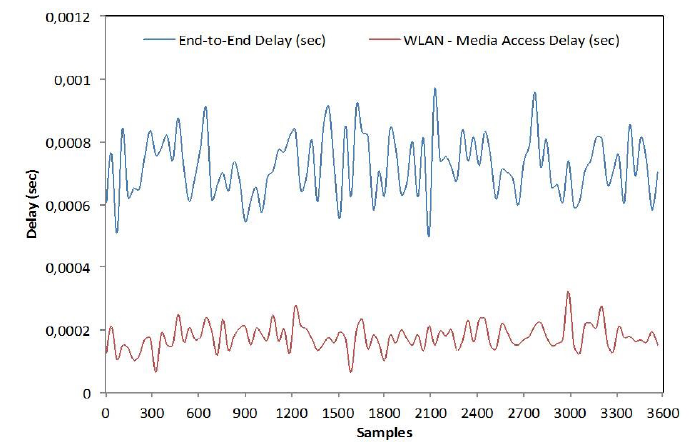
Figure 7. End-to-end delay & Media Access